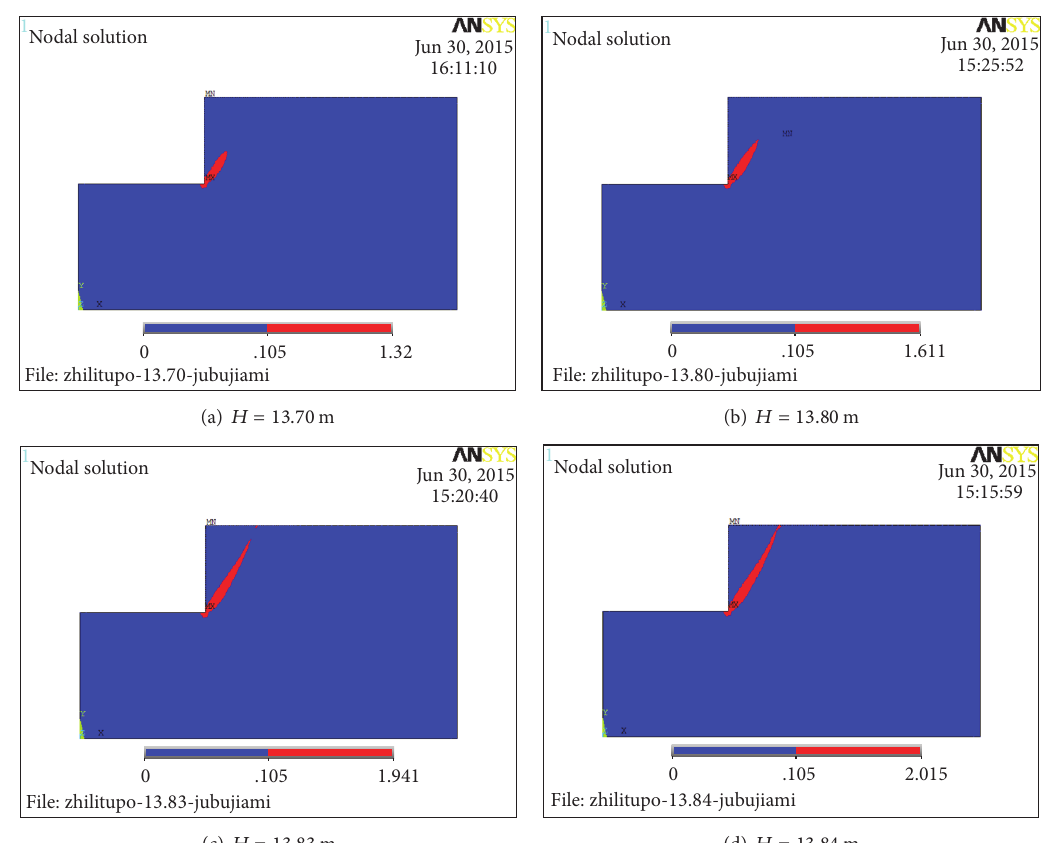
Figure 4: Contour of ultimate equivalent plastic strain of slope at different heights (unit: